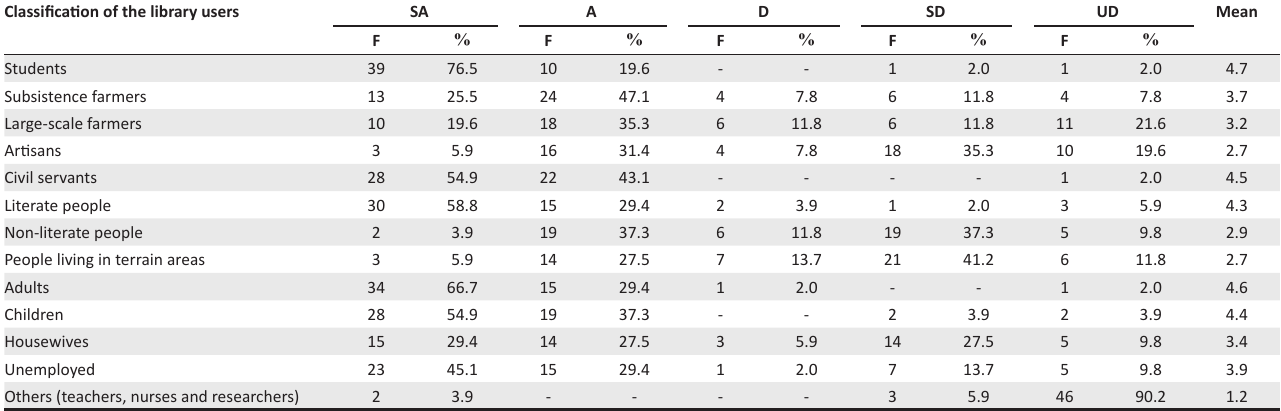
TABLE 4: Opinions of the heads of branch libraries on the classification of the library users ( N = 51). Classification of the library